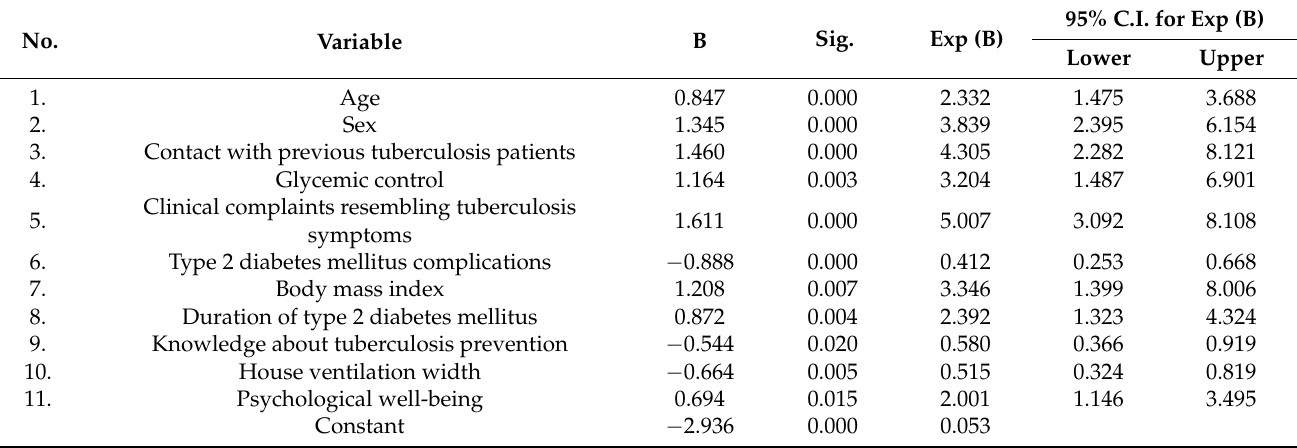
Table 2. Multiple logistic regression test results before tuberculosis predictive index on type 2 diabetes mellitus